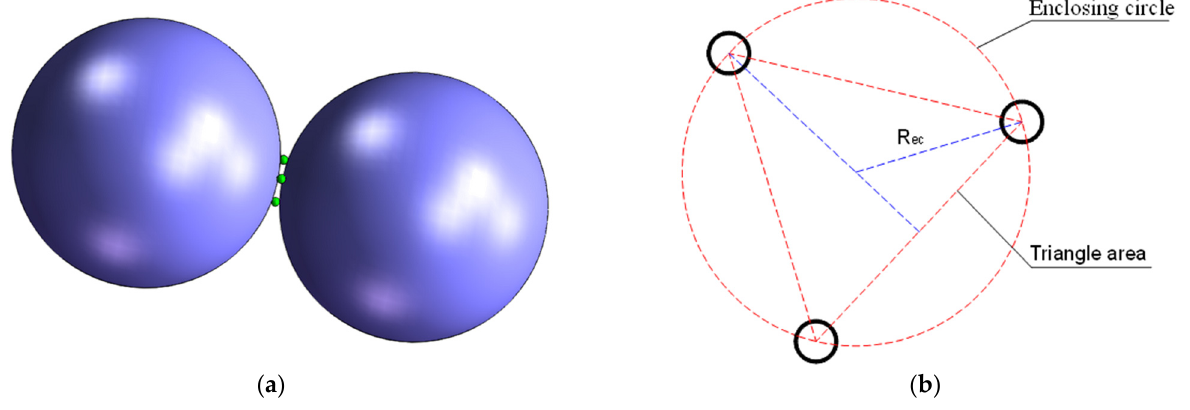
Figure 11. ( a ) Contact of fine coating particle and additive particles ( b ) Location of additive particles.